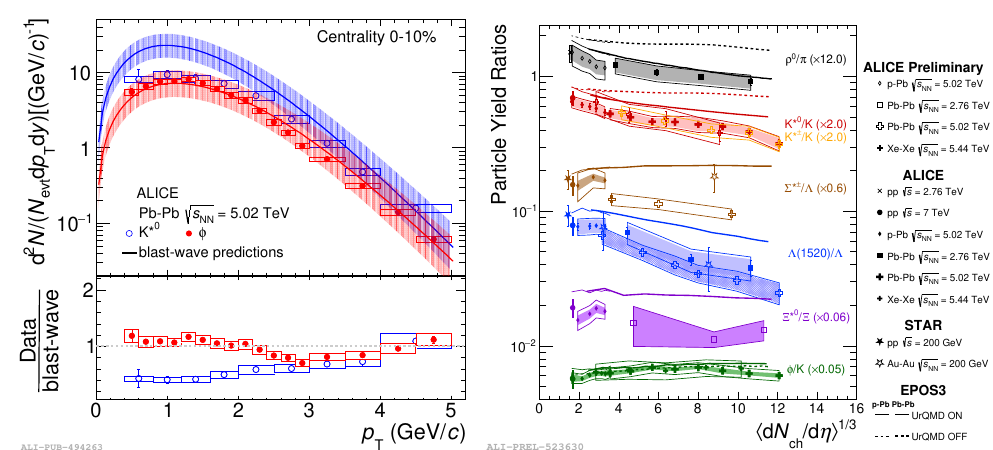
Figure 1. Left: transverse momentum distributions of K ∗ 0 (blue) and φ (red) resonances in Pb–Pb collisions at √ s NN = 5.02 TeV along with blast wave predictions. The shaded bands indicate the un- certainties in the fit parameters of the model distributions. The lower panels show the ratios of the measured distribution to the values from the model. Right: summary of p T -integrated yield ratios of di ff erent resonances to their ground state particles ( ρ/π , K 0 , ∗± / K, Σ ∗± / Λ , Λ (1520) /Λ , Ξ ∗ 0 /Ξ and φ / K) as 1 / 3 in pp, p–Pb, Xe–Xe and Pb–Pb collisions along with model predictions from a function of d N ch / d η (cid:28) (cid:27) EPOS3 (with and without URQMD) and STAR